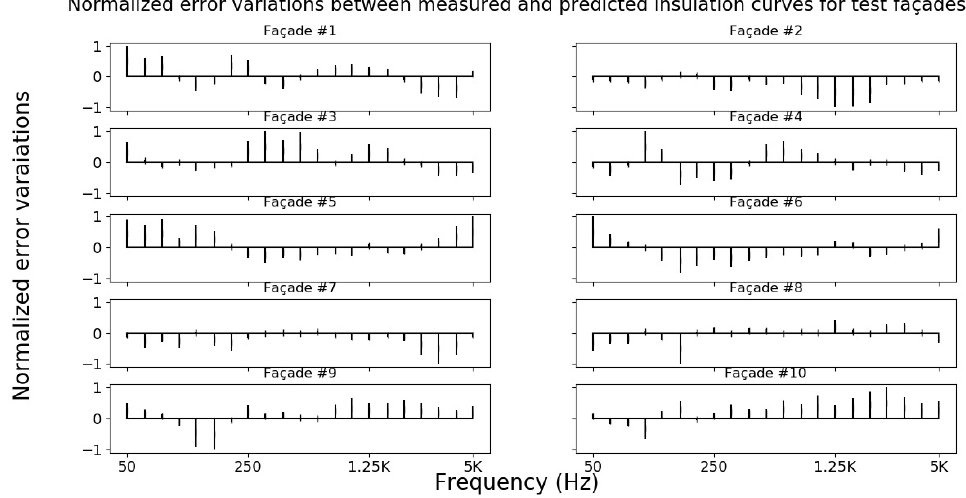
Figure 4. Normalized error distributions of estimated airborne reduction curves for tested walls.